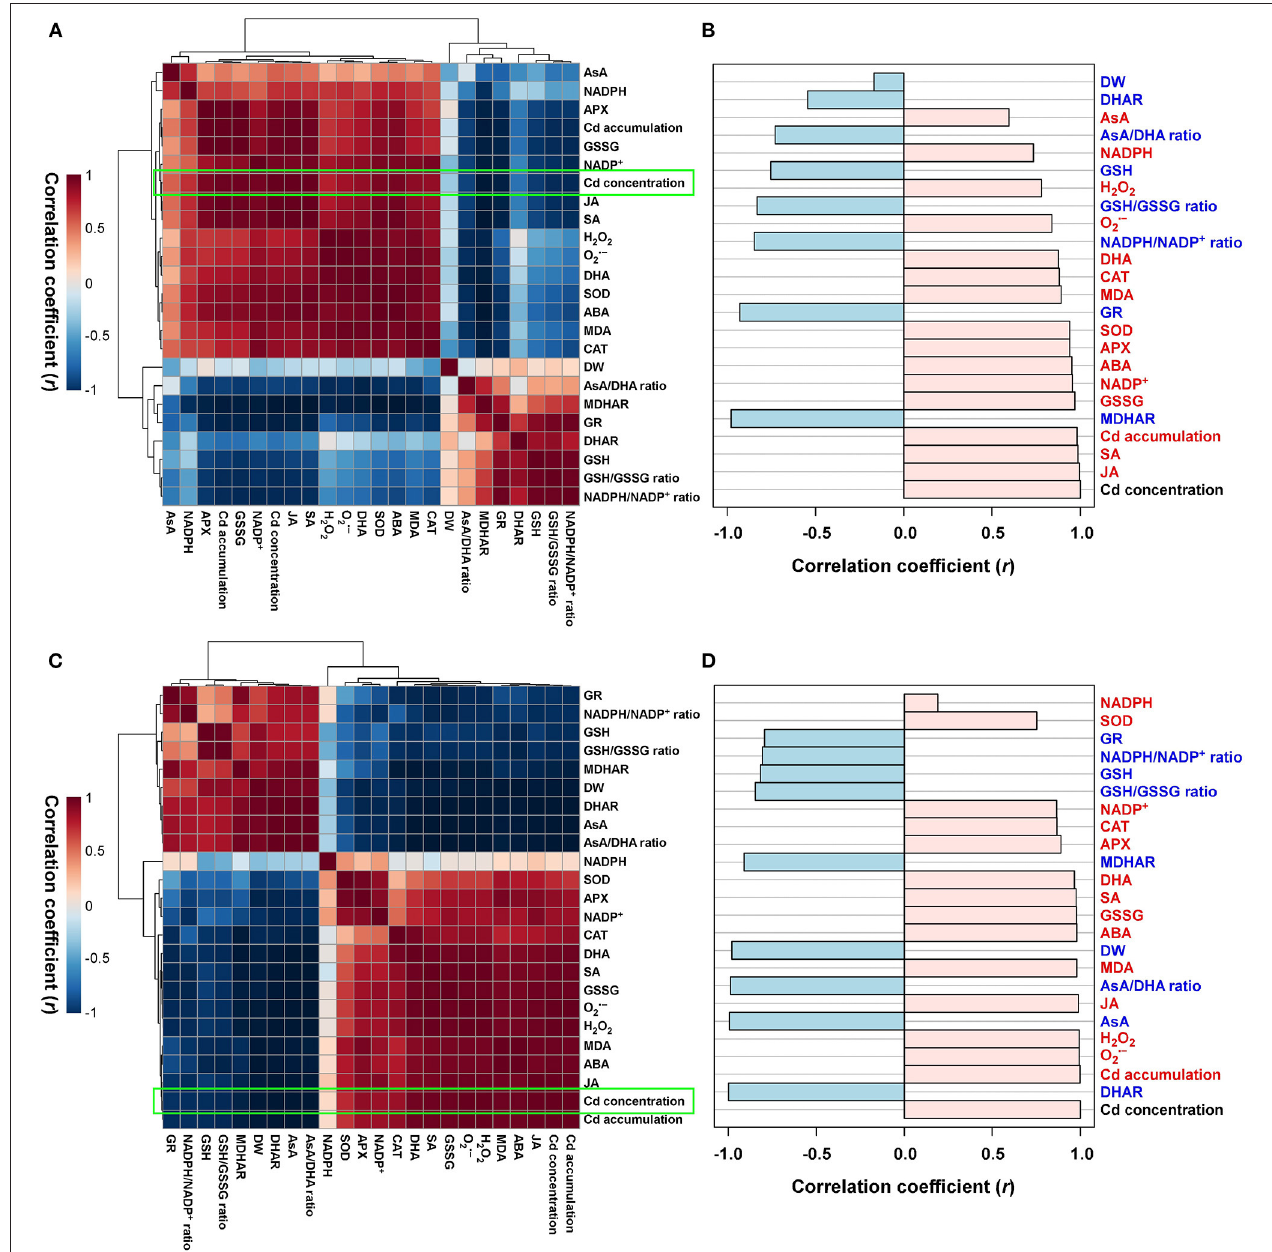
FIGURE 6 | Heatmap analysis of Pearson’s correlation coefficient ( r ) for the targeted metabolites of ROS, AsA/GSH/NADPH redox status, and stress-associated hormone status in the (A,B) roots and (C,D) shoots of Cd-stressed